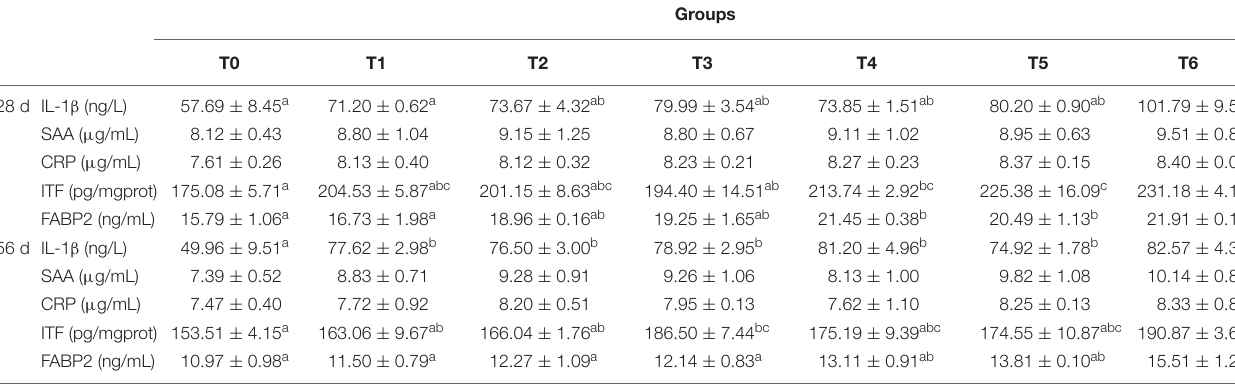
TABLE 5 | Effects of histamine on inflammation markers of grouper ( Epinephelus coioides ).